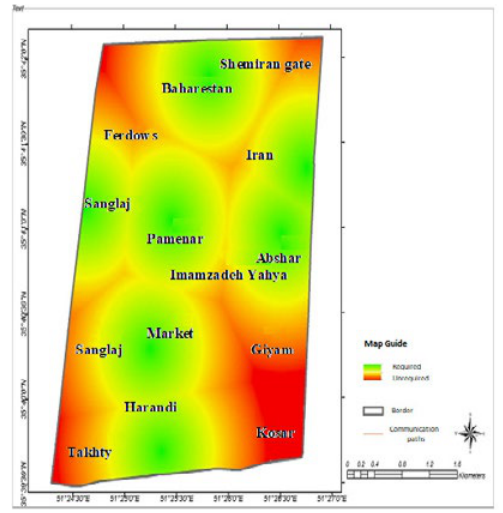
Fig. 11: Fuzzy distance layer from crisis Management centers Fig. 12: Fuzzy distance layer from fire stations